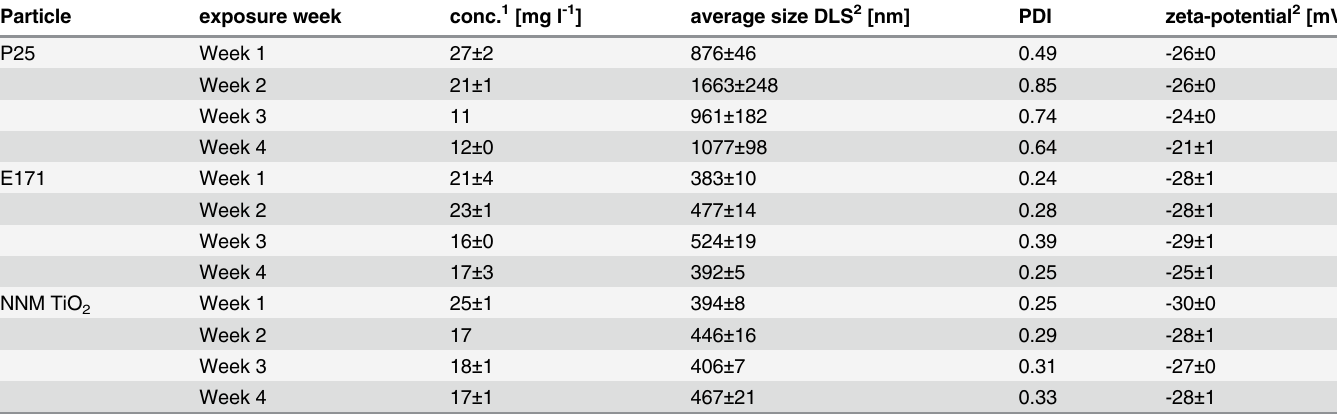
1 Concentration of total titanium in the suspension at the beginning of the exposure week (n = 3) for the highest concentrations of each particle (2). The lower concentration (1) was diluted 1:1 with FM medium. For weeks two and three, two P25 and two NNM TiO 2 samples were lost during digestion and thus only one sample could be used for determination of the concentration 2 Stock suspension was measured at every medium change